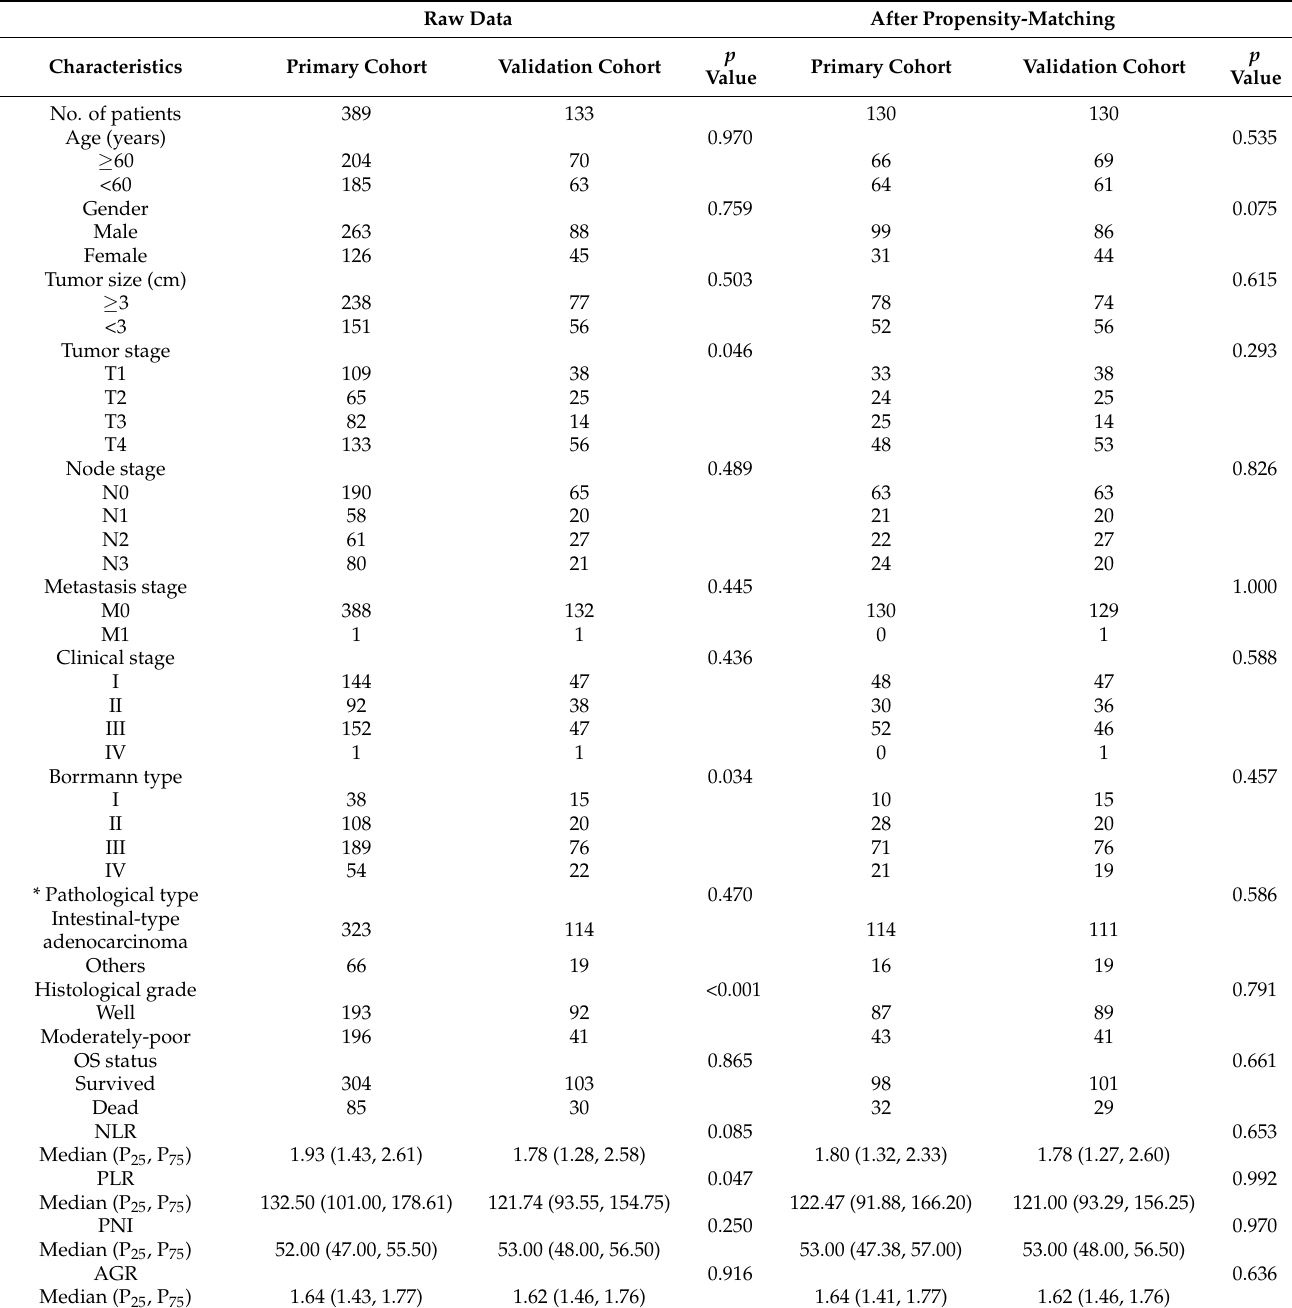
Table 1. The clinicopathological characteristics of the